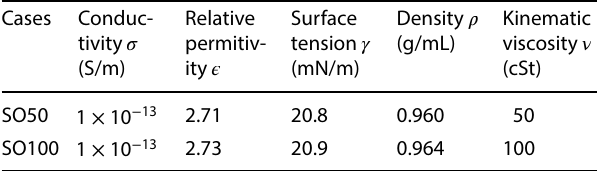
Table 1 Properties of the SO50 and SO100 silicone oils Cases